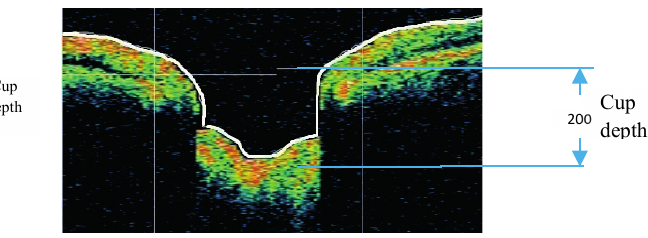
Fig. 7. OCT Normal image. Fig. 8. OCT abnormal